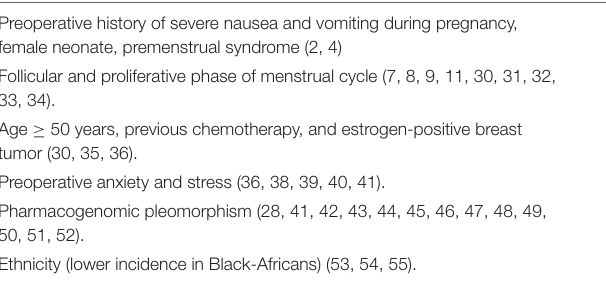
TABLE 2 | Physiologic changes associated with an increased risk of postoperative nausea and vomiting in the female population (Independent risk factors). Preoperative history of severe nausea and vomiting during pregnancy, female neonate, premenstrual syndrome (2, 4) Follicular and proliferative phase of menstrual cycle (7, 8, 9, 11, 30, 31, 32, 33, 34). Age ≥ 50 years, previous chemotherapy, and estrogen-positive breast tumor (30, 35, 36). Preoperative anxiety and stress (36, 38, 39, 40, 41). Pharmacogenomic pleomorphism (28, 41, 42, 43, 44, 45, 46, 47, 48, 49, 50, 51,